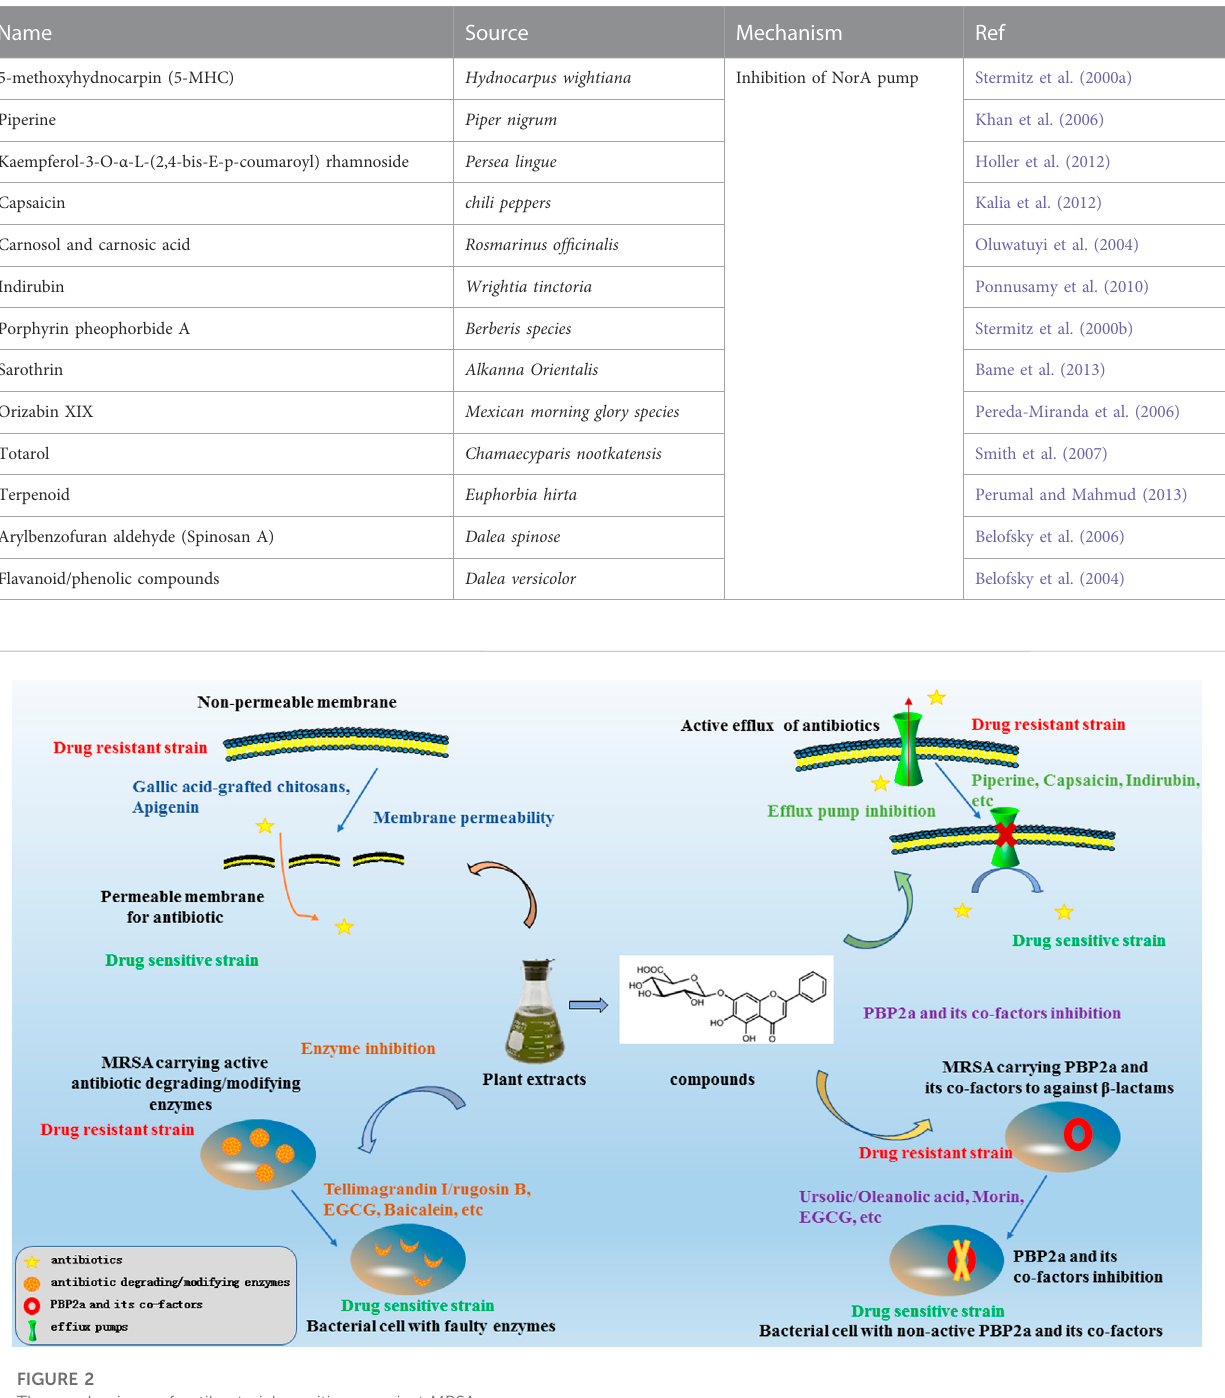
TABLE 5 The compounds from natural products that inhibit NorA pump.